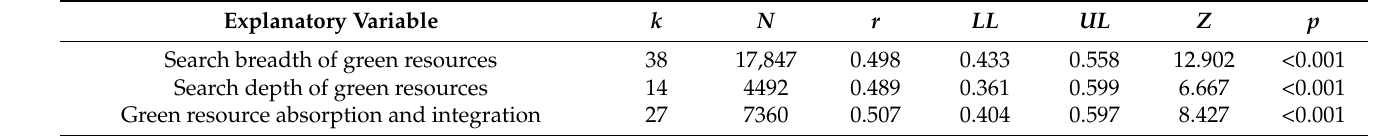
Table 4. Analysis Results of the Random Effect Model of the Main